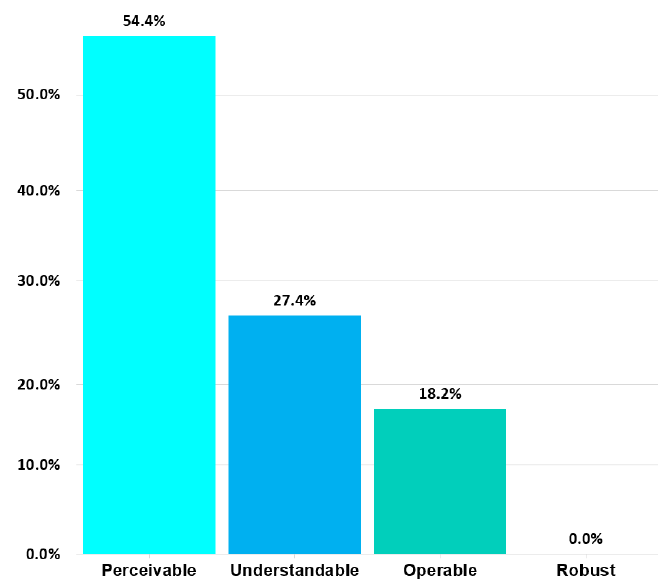
Figure 5. Successes of the WCAG principles in manual evaluation.